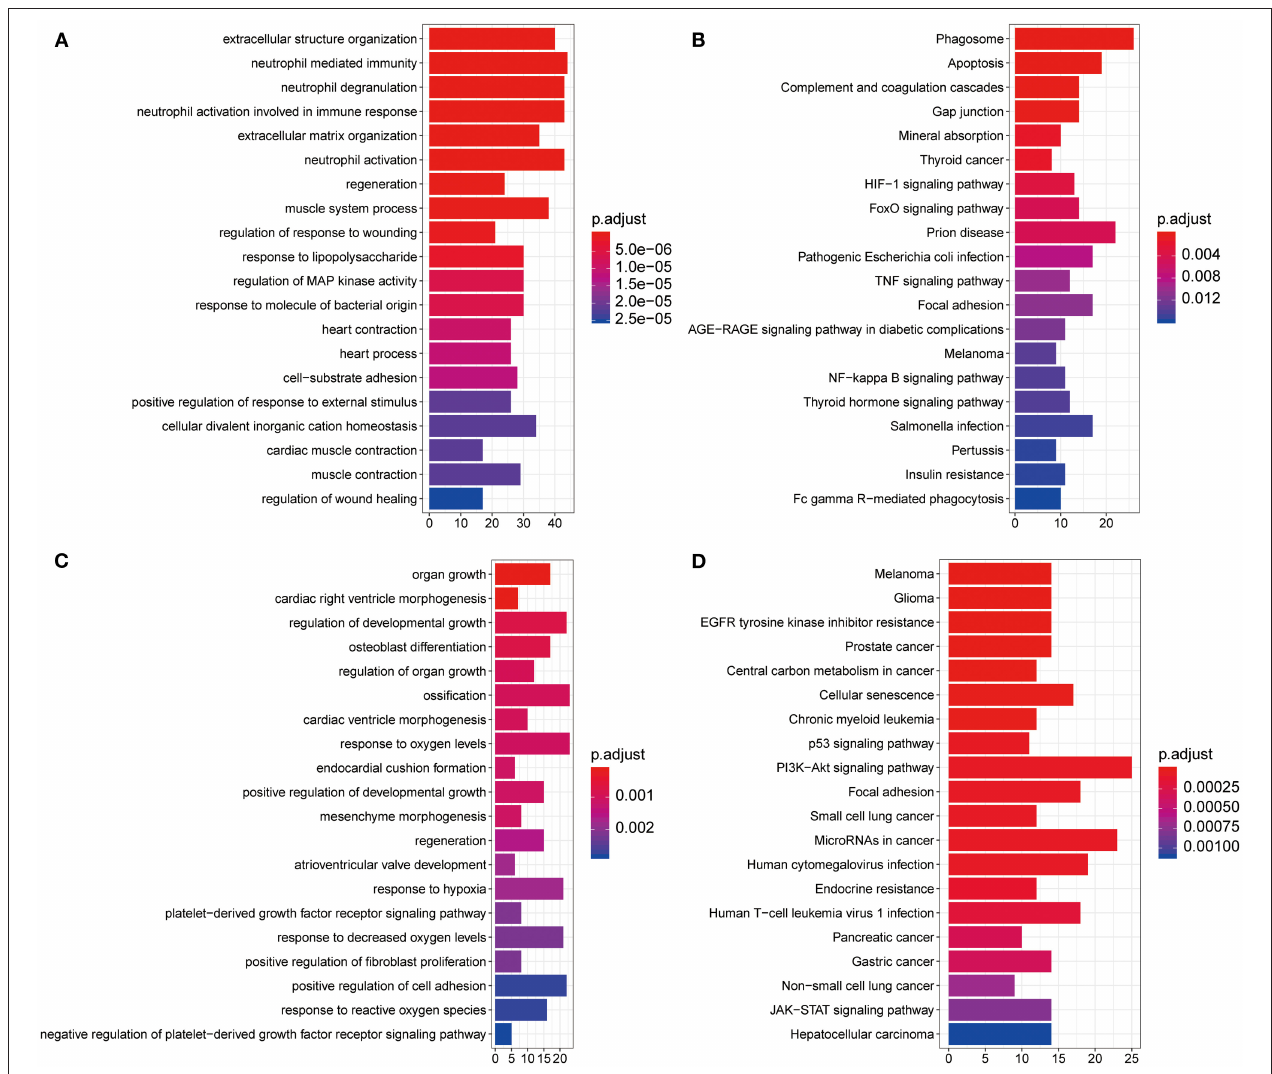
FIGURE 2 | Gene Ontology (GO) and Kyoto Encyclopedia of Genes and Genomes (KEGG) pathway enrichment analysis. (A) Histogram of the top 20 most significantly enriched GO terms from DEGs in GSE36961. The x axis shows number of mRNAs, and the y axis shows the name of GO terms. (B) The top 20 most significantly enriched KEGG pathways of DEGs. The x axis shows number of mRNAs, and the y axis shows the name of KEGG pathways. (C,D) Histogram of the top 20 most significantly enriched GO terms (C) and KEGG pathways (D) from DEMs in GSE36946. DEGs, differentially expressed genes; DEMs, differently expressed